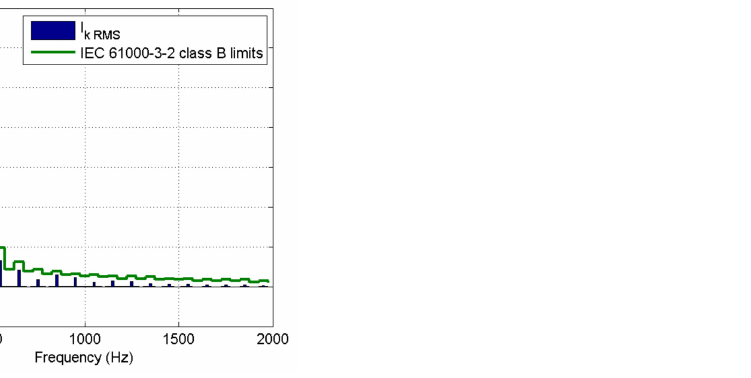
Figure 10. Testing for harmonic current emissions. RMS values of the harmonic components of the current drawn by the tested drive for the motor loaded with half the rated torque at n = 5000 rpm and for the PWM duty cycle of 40%. A moderated load and speed operation does not cause the current harmonics to exceed the standard limits.